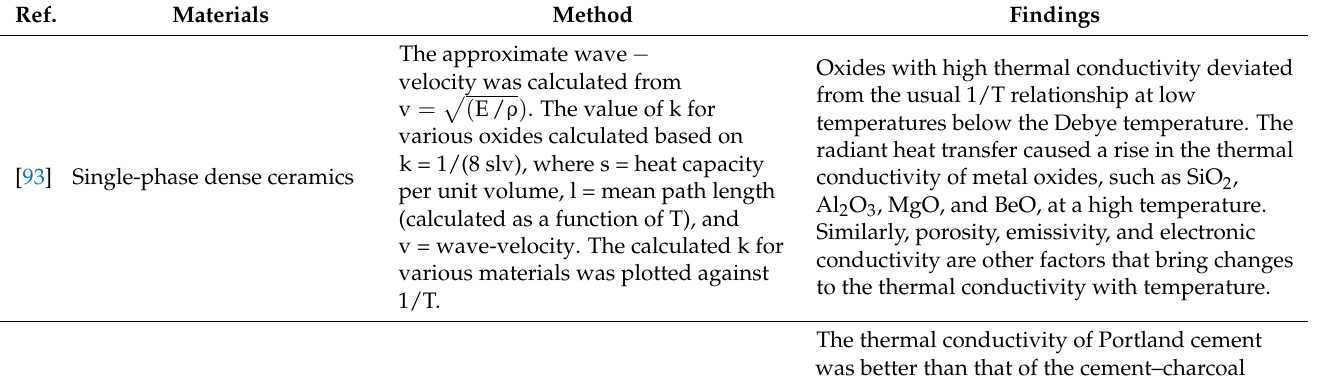
Table 2. Summary of thermal properties of biofiber-reinforced